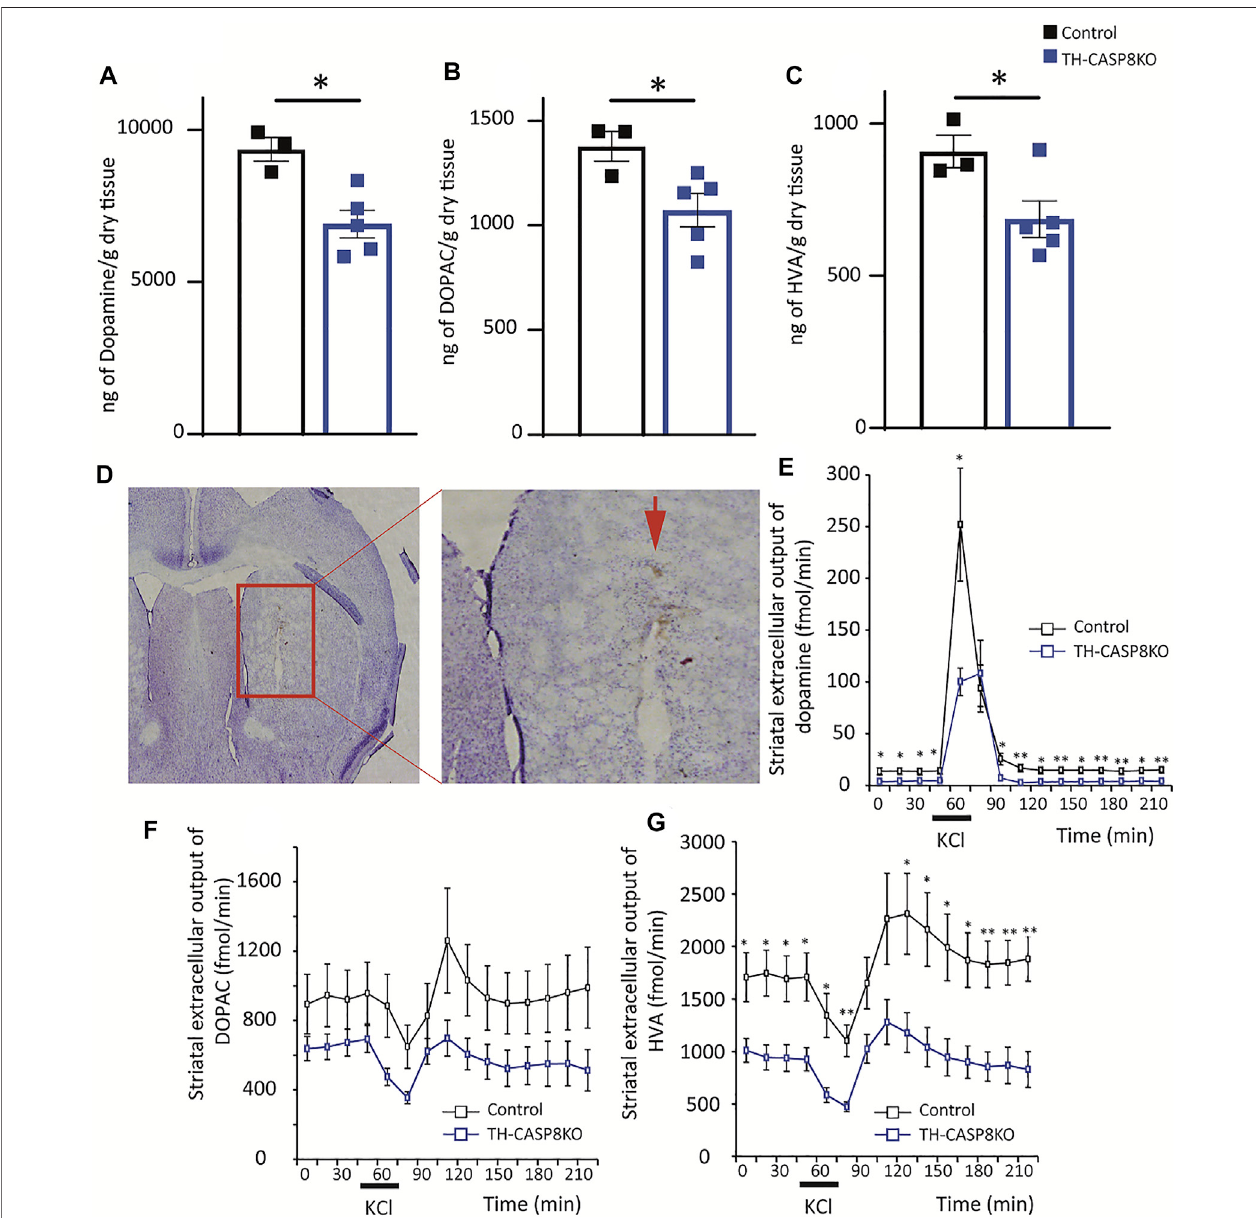
FIGURE3| Effectof CASP8 deletiononDAanditsmetaboliteslevelsinthestriatum.Quanti fi cationbyHPLCofDA (A) anditsmetabolitesDOPAC (B) andHVA (C) inthestriatumofcontrolandTH-CASP8KOanimals. (D) Coronalsectionshowingtheplacewherethemicrodialysisrecordingcannulawaslocated(redarrow).Scalebar 400 and 150 µm. Effect of 60 mM potassium perfusion on extracellular levels of DA (E) , DOPAC (F) , and HVA (G) in the striatum of control and TH-CASP8KO animals. Data are expressed as mean ± SEM of n = 6-7 mice/group. The two-tailed unpaired t test was used.*, p < 0.05; **, p < 0.01 versus control mice.